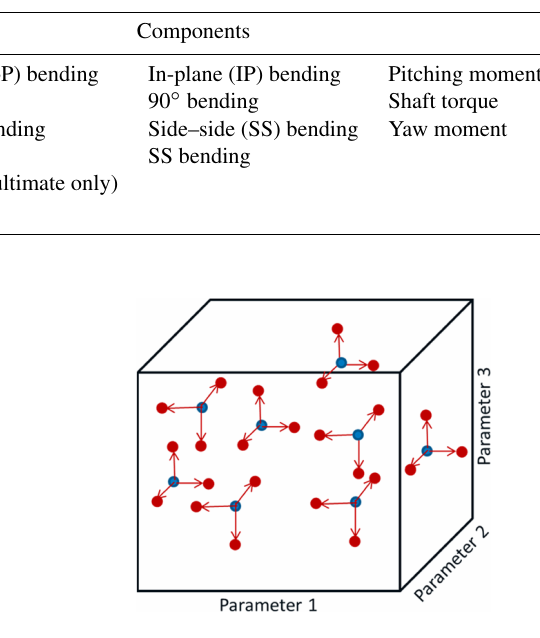
Figure 2. Radial EE approach representation for three input pa- rameters. Blue circles indicate starting points in the parameter hy- perspace. Red points indicate variation in one parameter at a time. Each variation is performed for 10% of the range over which the parameter may vary, either in the positive or negative